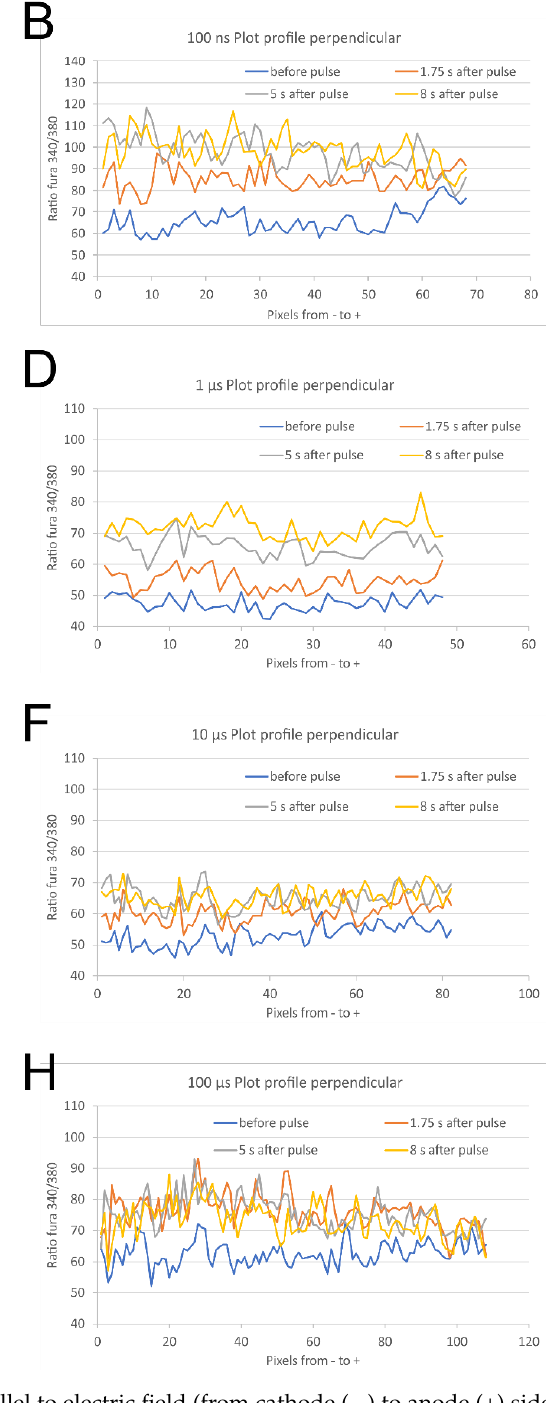
Figure 4. A plot profile of the cell along the longest axis parallel to electric field (from cathode (−) to anode (+) side) of relative Ca 2+ concentration as expressed in Fura-2 ratio 340/380 of a representative parallel and perpendicular cell, at different times with respect to pulse application. Cells were exposed to a single 100 ns, 40 kV/cm ( A , B ), 1 µ s, 2500 V/cm ( C , D ), 10 µ s, 1000 V/cm ( E , F ), and 100 µ s, 400 V/cm ( G , H ) pulse. Green arrow in ( G ) indicates the progression of Ca 2+ ions in